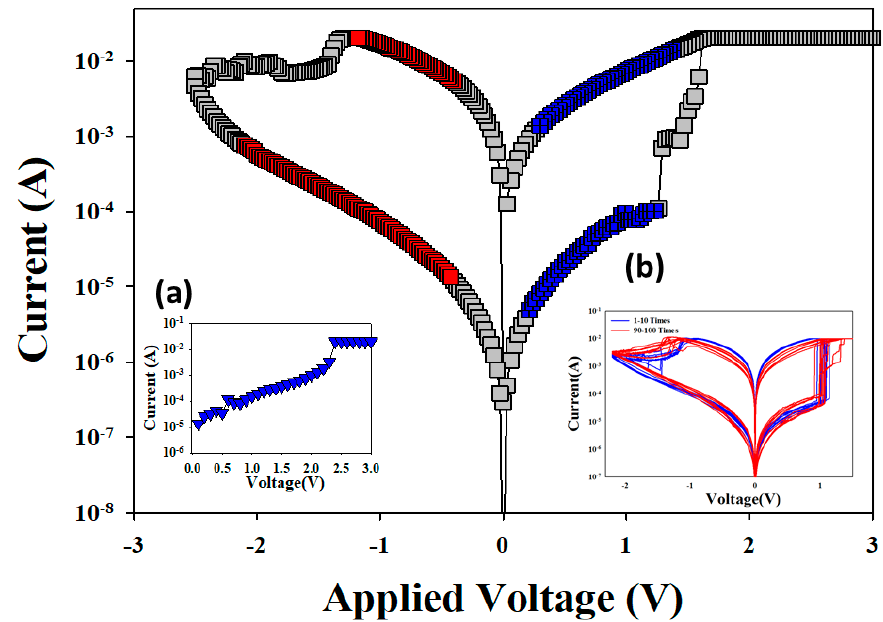
Figure 3. The typical I-V switching properties of the vanadium thin film RRAM devices for ( a ) the initial forming process, and ( b ) metal-insulator-metal (MIM)